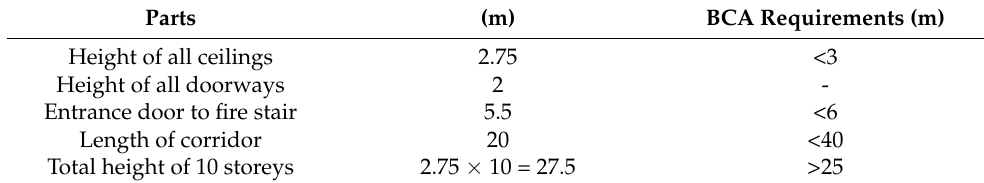
Table 1. Dimension of the building. Parts (m) BCA Requirements (m) Height of all ceilings 2.75 <3 Height of all doorways 2 - Entrance door to fire stair 5.5 <6 Length of corridor 20 <40 Total height of 10